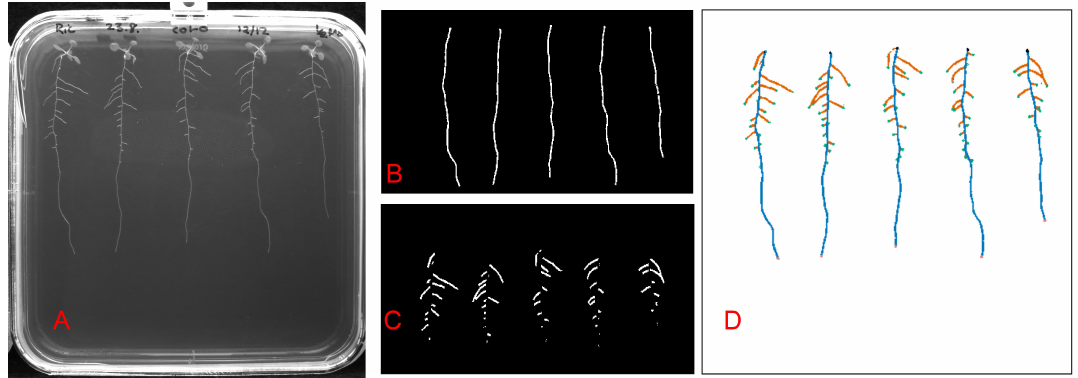
Figure 2. Sample image set showing the process and output from RootNav 2.0 for root image annotation. ( A ) shows the raw sample root input image. ( B , C ) The binary mask of primary and lateral roots extracted from RootNav 2.0. The PNG color output from this image is displayed in ( D